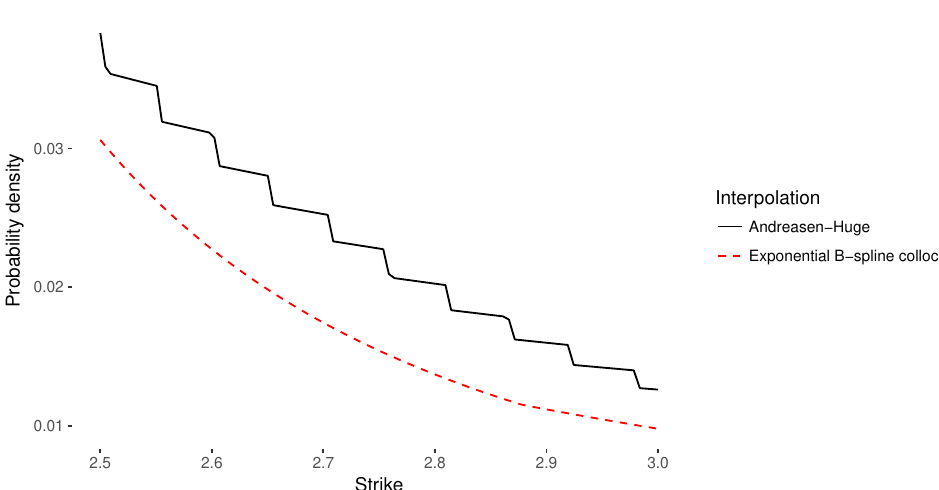
Figure 6. Implied probability density for the exponential B-spline collocation and Andreasen–Huge techniques, for strike moneyness K ∈ [ 2.5,3.0 ] , calibrated to the market data of Table A2 in Appendix A. The B-spline has a knot located at K =